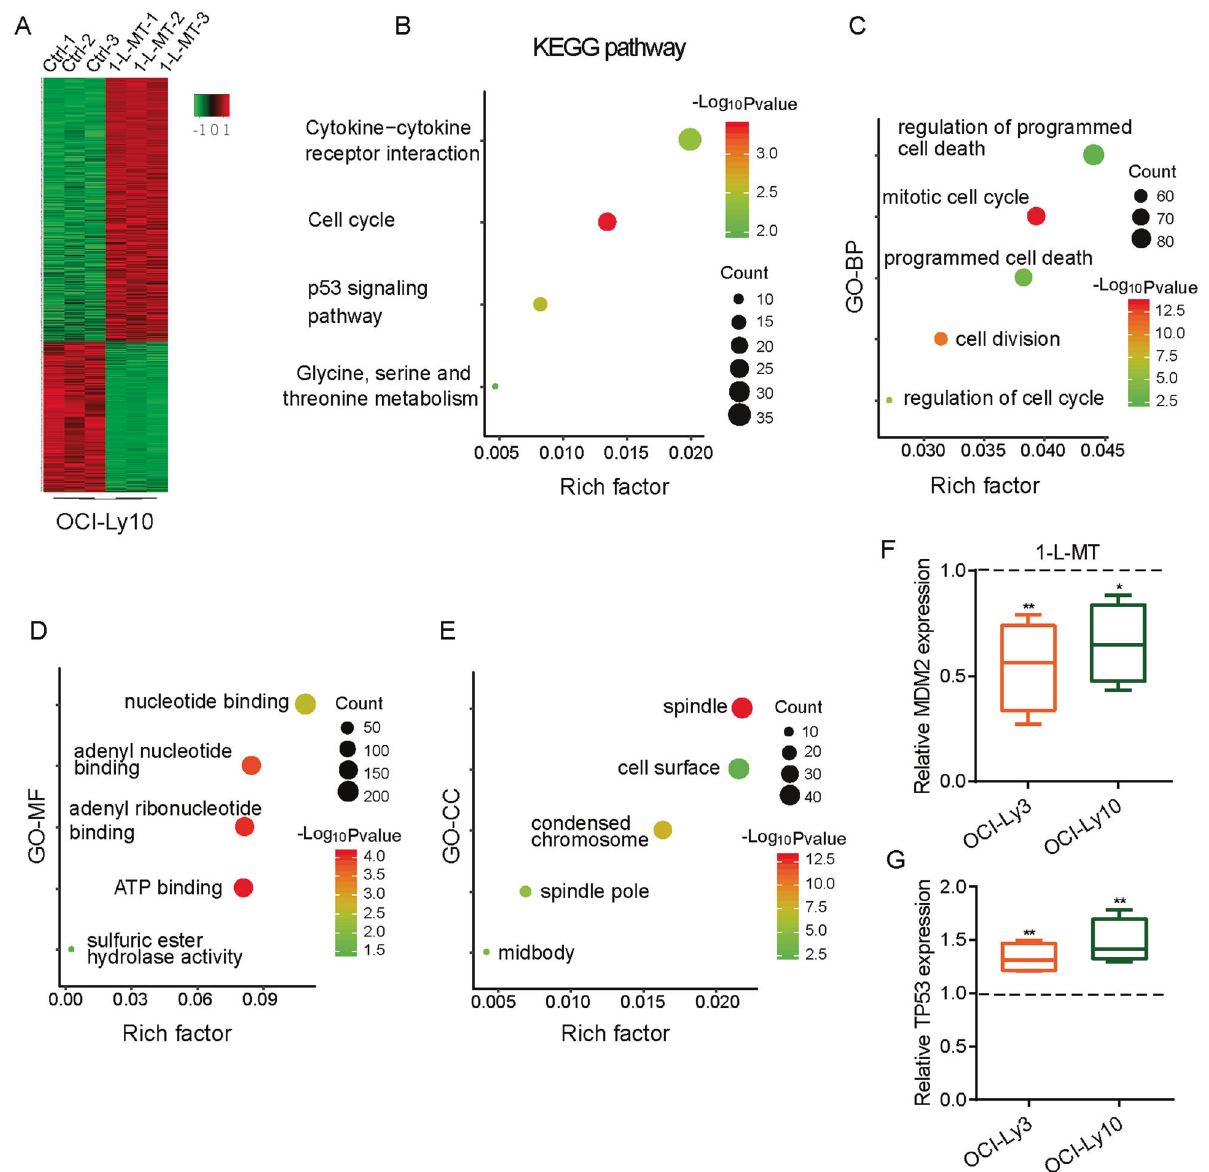
Fig. 5 MDM2 and TP53 were genes downstream of IDO1 in DLBCL. A The cluster heat map is classi fi ed as DEGs in IDO1 inhibition compared with Ctrl OCI-Ly10 cells. B – E Signi fi cantly enriched KEGG ( B ) and GO ( C – E ) pathway terms of the DEGs in IDO1 inhibition OCI-Ly10 cells were identi fi ed. F RT-qPCR was used to assess the mRNA levels of MDM2 in 1-L-MT and Ctrl OCI-Ly3/OCI-Ly10 cells. G RT-qPCR validation of TP53 mRNA levels in 1-L-MT and Ctrl OCI-Ly3/OCI-Ly10 cells. Statistical analysis was analyzed with a two-sided student ’ s t-test. * P < 0.05 and ** P <